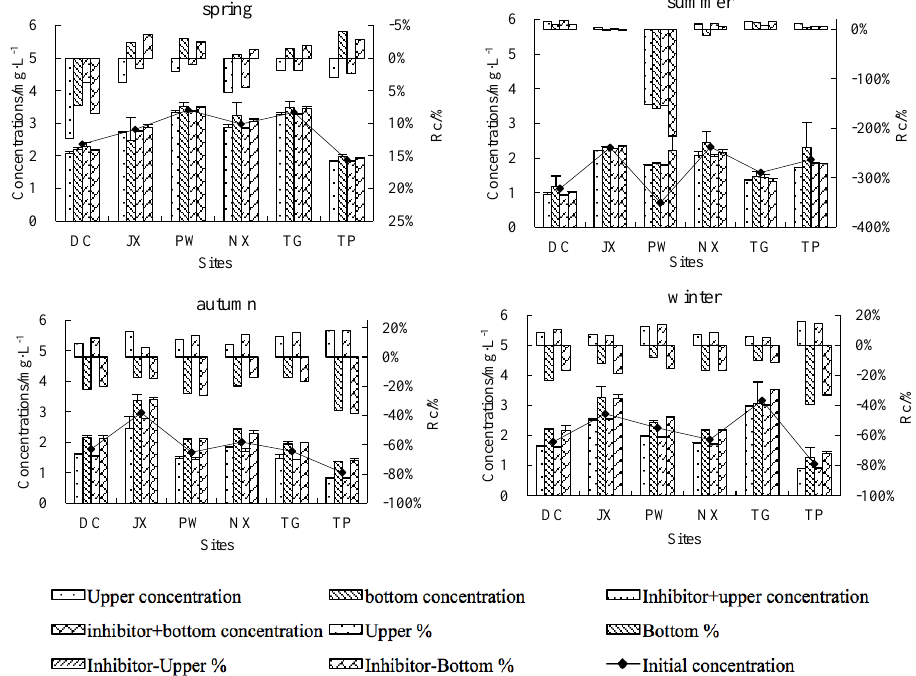
Figure 6. Initial NO 3 − -N concentrations (line), final upper- and bottom-layer NO 3 − -N concentrations (lower histogram) and percent change from initial NO 3 − -N concentrations (upper histogram). A negative percentage indicates an increase in concentrations and vice versa.